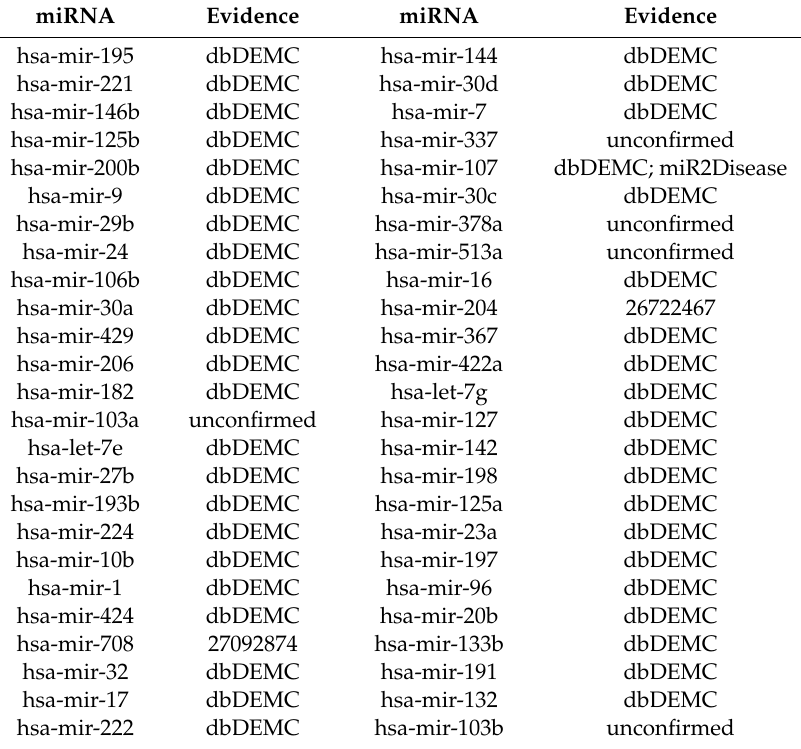
Table 1. Prediction of the top 50 potential EN-related